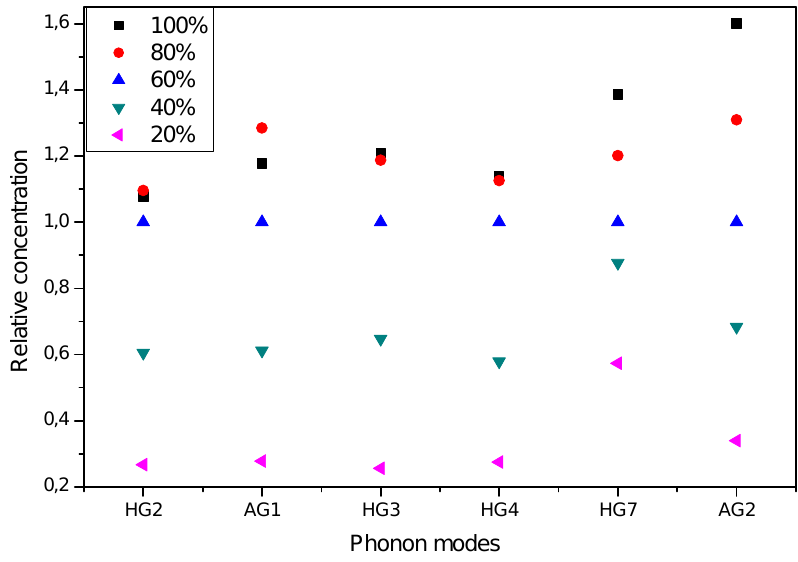
Figure 6. Calculated average intensity ratios, normalized on the 60% filling factor intensities, between modes of the C 60 in the C 60 @(10,10) peapod crystal and the RBLM (Hg(2), Ag(1), Hg(3), Hg(4)) or G-mode (Ag(2)) of the (10,10) BN